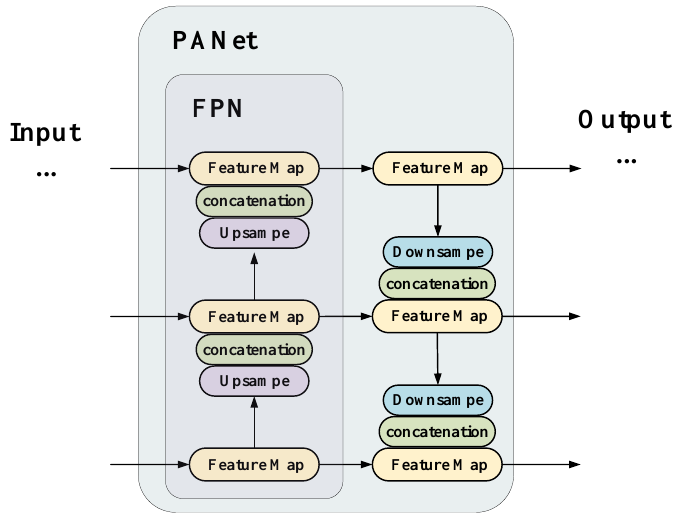
Figure 4. Schematic of the PANet module.